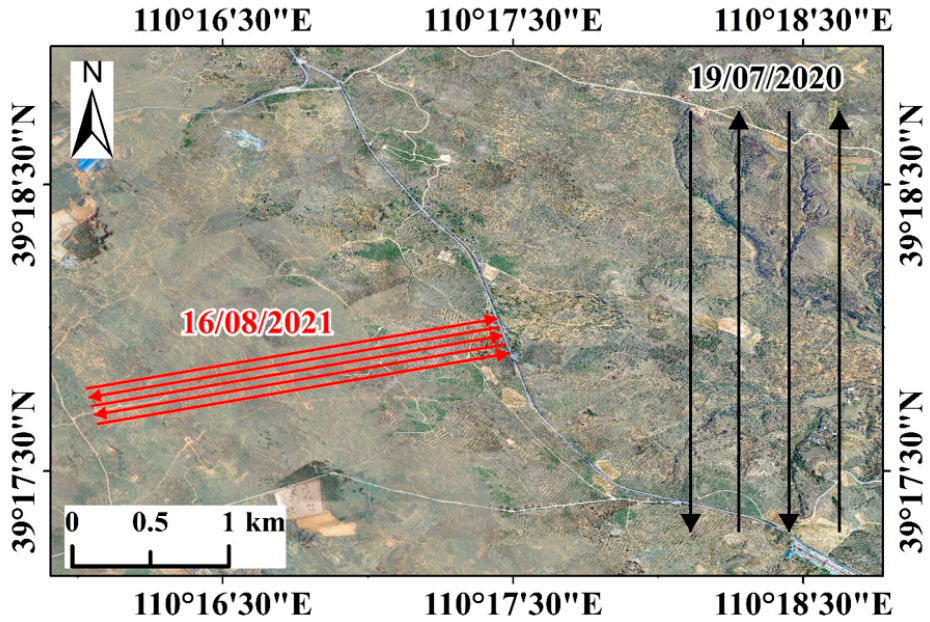
Figure 1. Geographic location of the study area and schematic flight lines for 19 July 2020 (black) and 16 August 2021 (red).